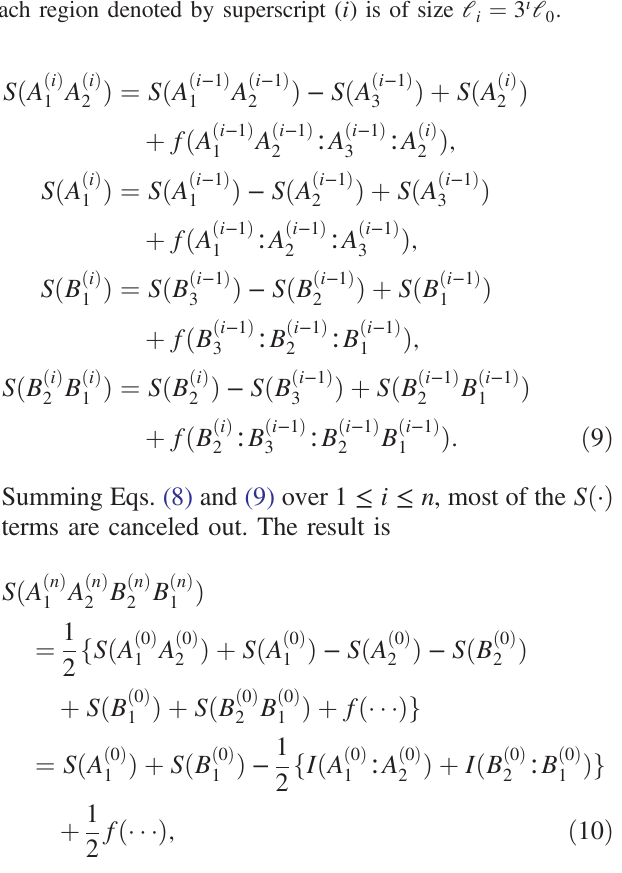
FIG. 2. Partitioning of the system for the proof of Lemma 7. The region of interest, which is of size 4 l size l . We recursively decompose the two end regions A ð i Þ 1 and B ð i Þ 1 , respectively, into three regions of size l n − 1 Þ ð i − 1 Þ A ð i Þ 1 ¼ A ð i 1 þ A 2 and B